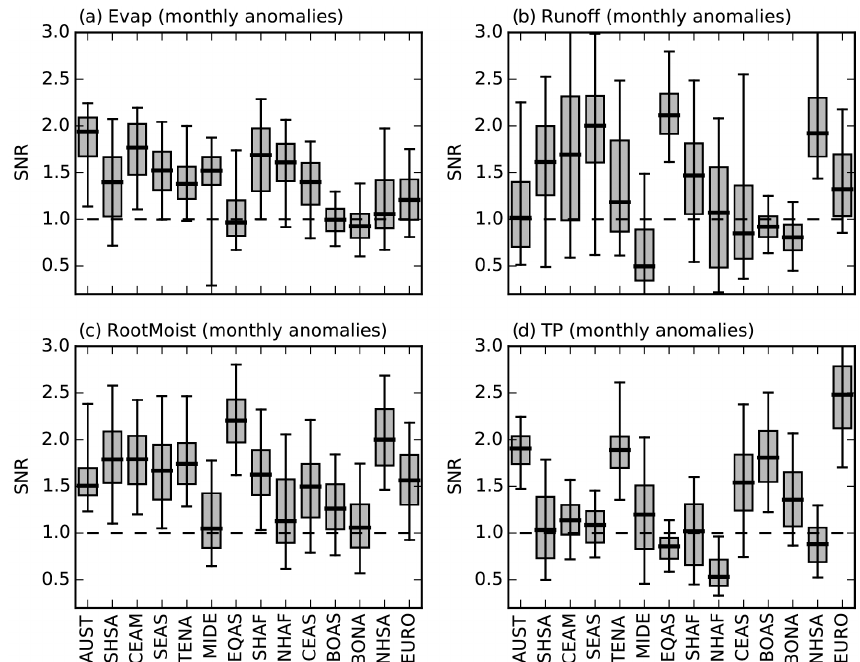
Figure 3. Distribution of the SNR of monthly anomalies over different BIOMES (horizontal axis; see Fig. 4) for evapotranspiration (a) , runoff (b) , root zone soil moisture (c) and precipitation (d) . The boxplots represent the spatial variability of the individual pixels of SNR in each biome extending from percentile 5 to 95 (whiskers), percentiles 25 to 75 (box) and median (horizontal